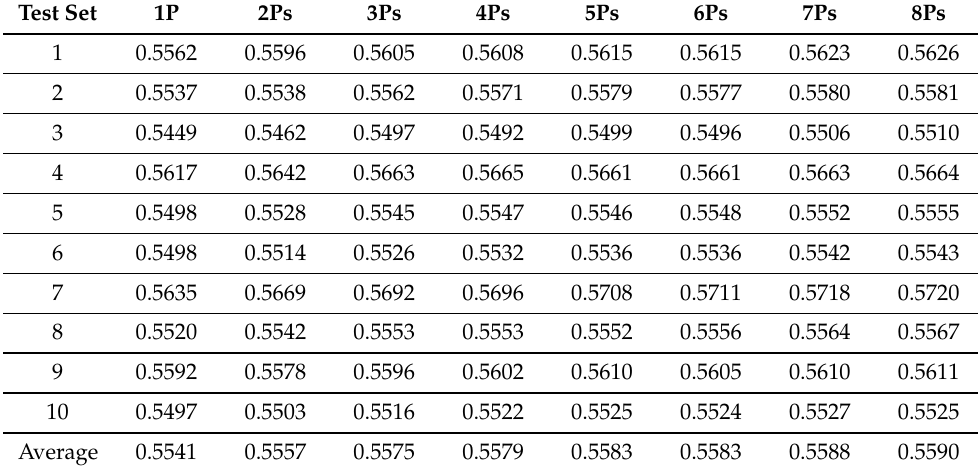
Table 9. Experiments with model